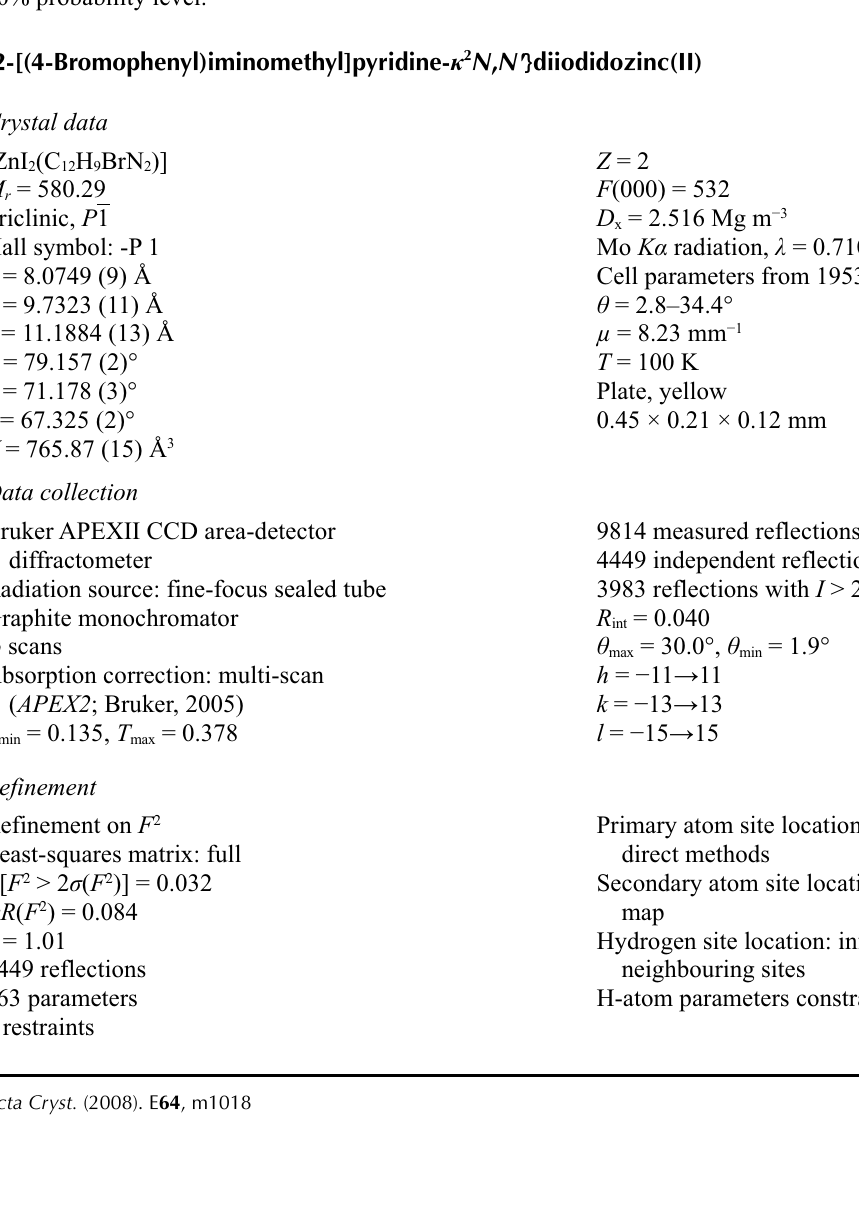
The molecular structure of the title compound showing the atom-labelling scheme and thermal ellipsoids drawn at the 50% probability